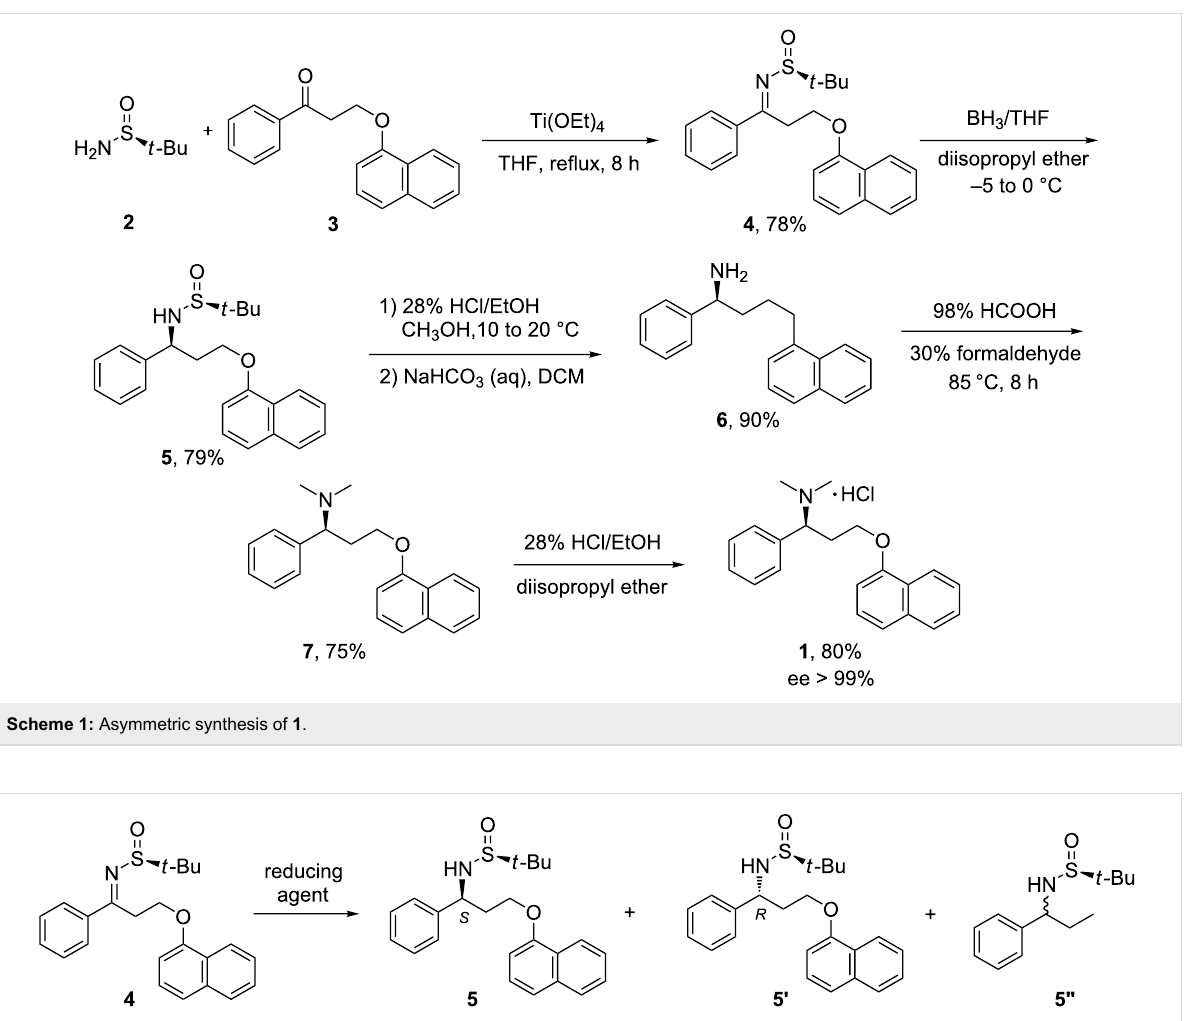
Scheme 2: Reduction of sulfinylimine 4